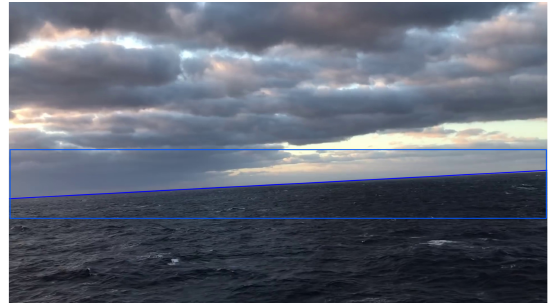
Figure 7. Clipped image based on prior